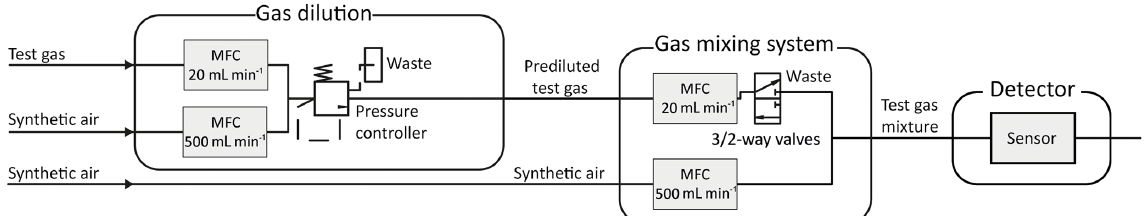
Figure 3. Schematic structure of the gas mixing